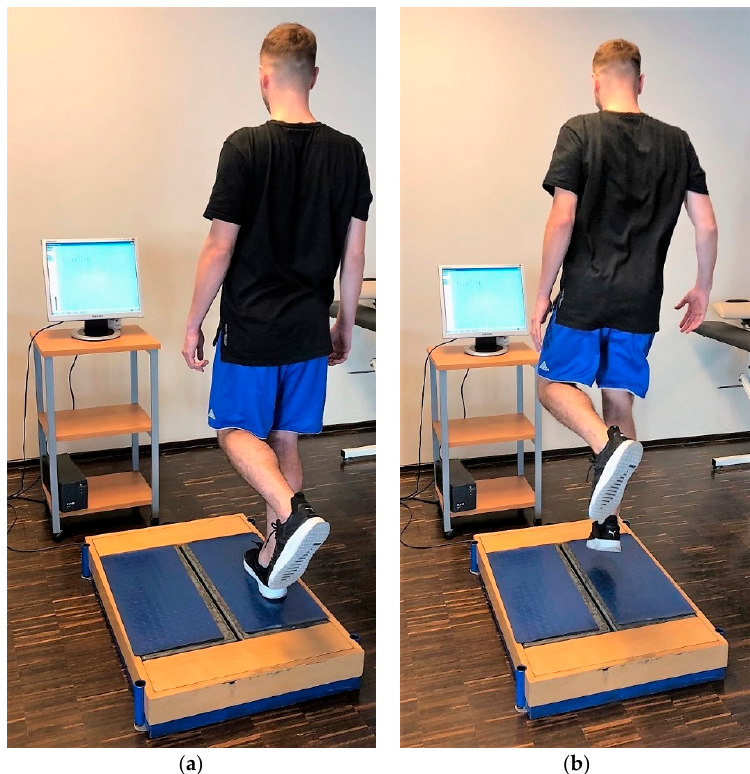
Figure 3. ( a ) The starting position for the vertical ground reaction force (vGRF) measurements during single-leg vertical hops; ( b ) the single-leg vertical hop.